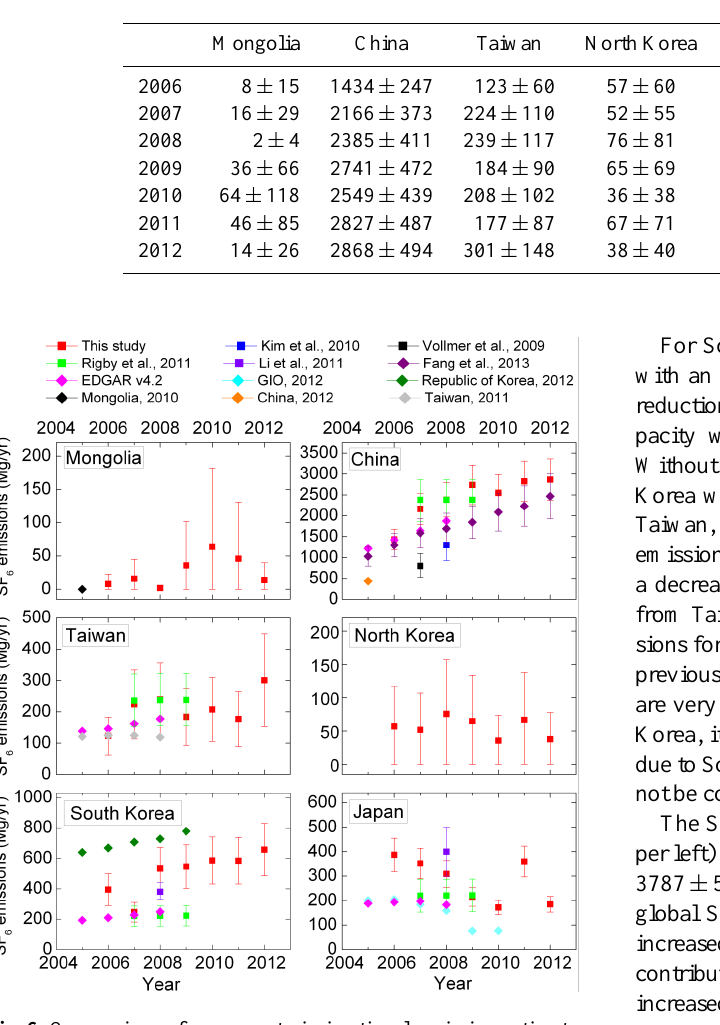
Table 3. SF 6 emissions (Mgyr − 1 ) per country/region for the period 2006–2012. Results are shown for the mean a posteriori emissions from the inversion ensemble, and the corresponding uncertainties estimated based on the overall relative uncertainties in Table 2.